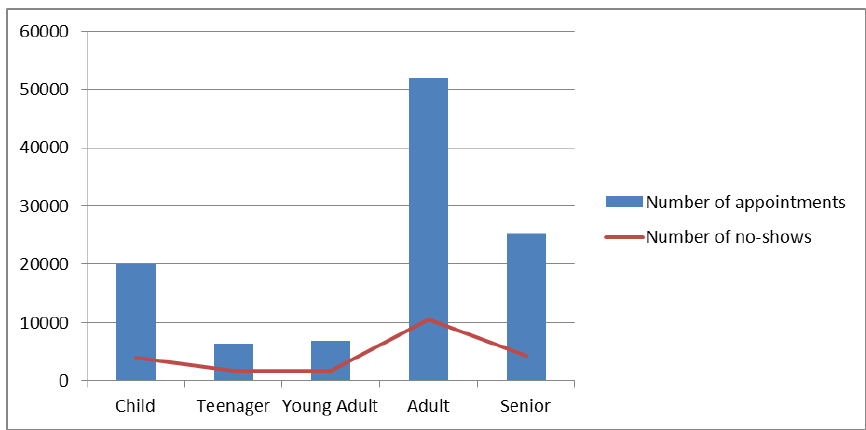
Figure 3. Distribution of no-show based on mapped age.